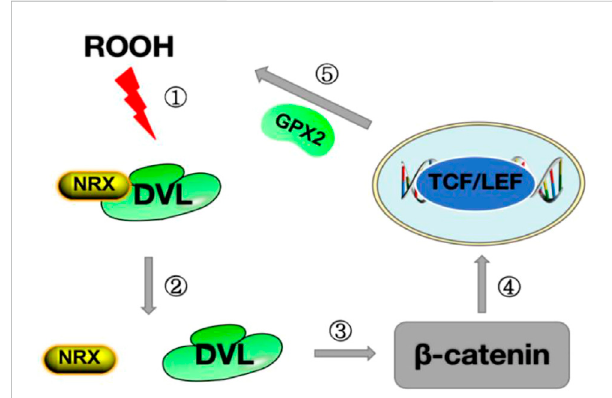
FIGURE 2 DiagramoftheWntpathwaymechanism.Step ① :ROOHoxidizes NRX on DVL;Step ② : The structure of NRX is changed after oxidation, releasing DVL;Step ③ After the release of DVL, inhibit β -catenin degradation and stabilize the expression of β -catenin in the cytoplasm;Step ④ : β -cateninentersthenucleusandbindstoTCF/LEF to promote the synthesis of GPX2;Step ⑤ : GPX2 is released, ROOH is cleared, and oxidative stress is reduced.ROOH stands for lipid peroxide; DVL stands for Disheveled protein;NRX stands for Nuclear Redox Protein; GPX2 stands for glutathione peroxidase 2.